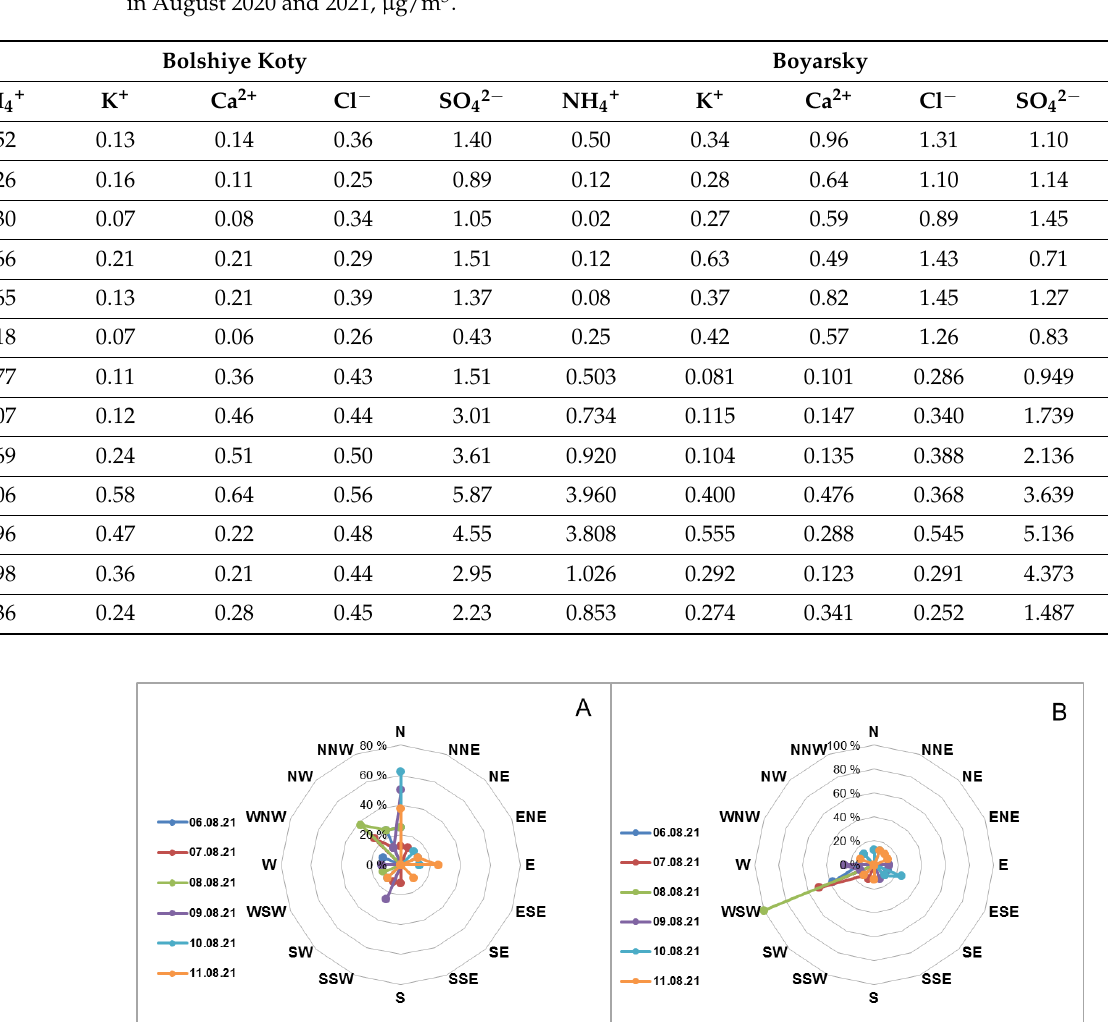
Figure 10. Prevailing wind directions at the Bolshiye Koty ( A ) and Boyarsky ( B ) research stations on 6 to 11 August 2021 [27,33].